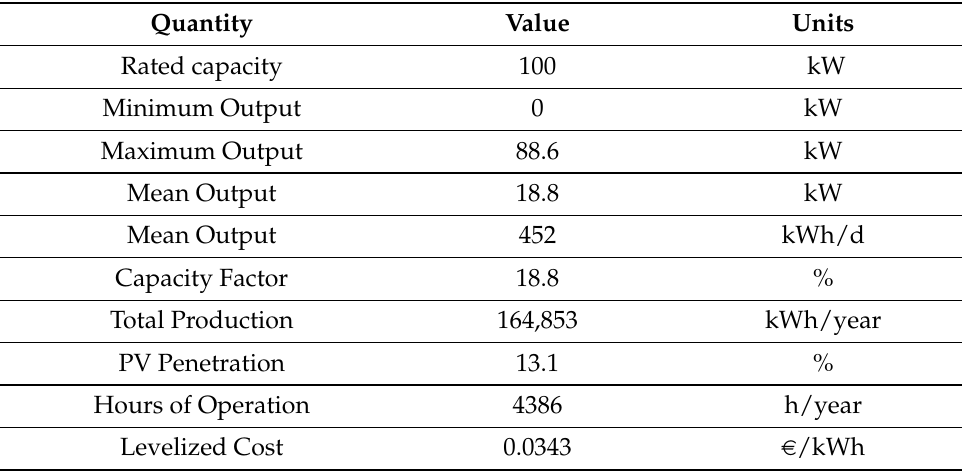
Figure 9. PV Power output. Table 10. PV Scheme Simulation Results.